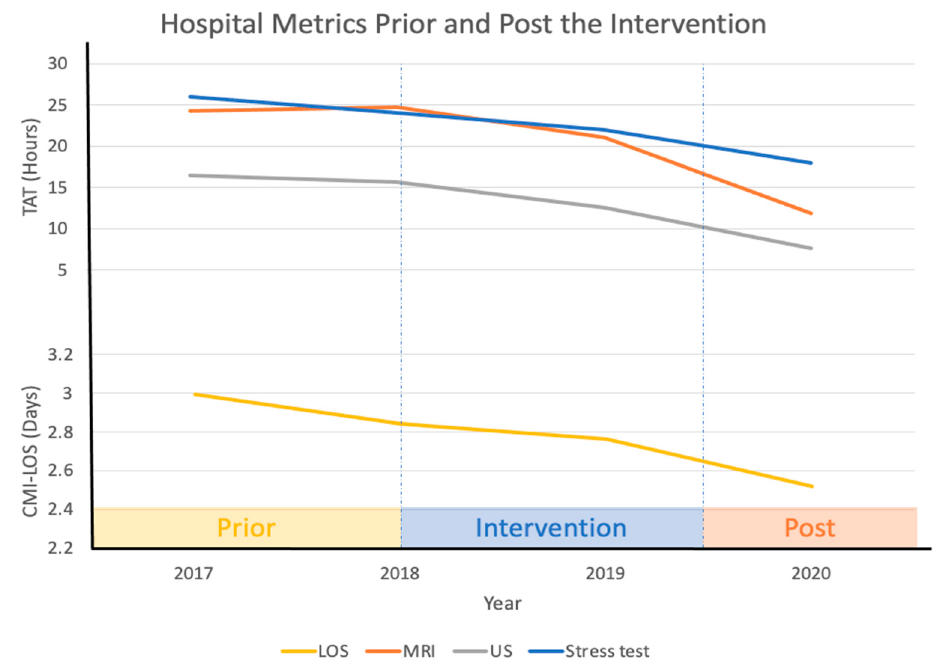
Figure 3. Pre- and post-intervention hospital metrics. Abbreviations: turnaround time (TAT); case mix index (CMI); length of stay (LOS); magnetic resonance imaging (MRI); ultrasound (US).